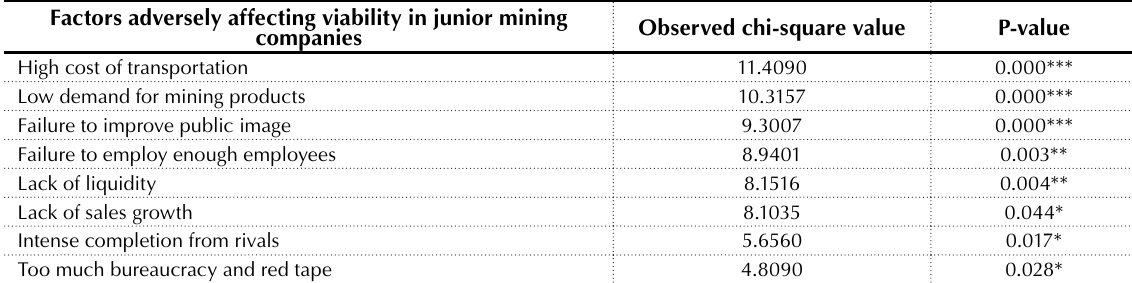
Table 5. Significant associations obtained from cross-tab